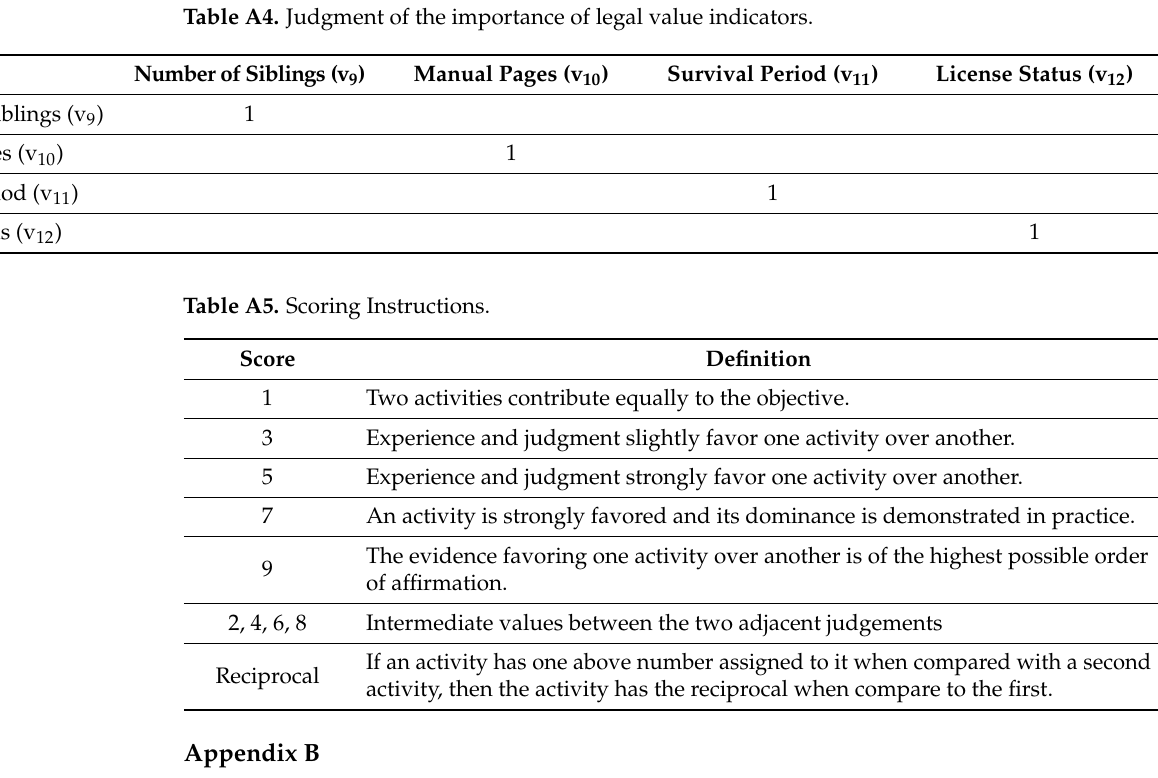
Table A6. Patent value scoring